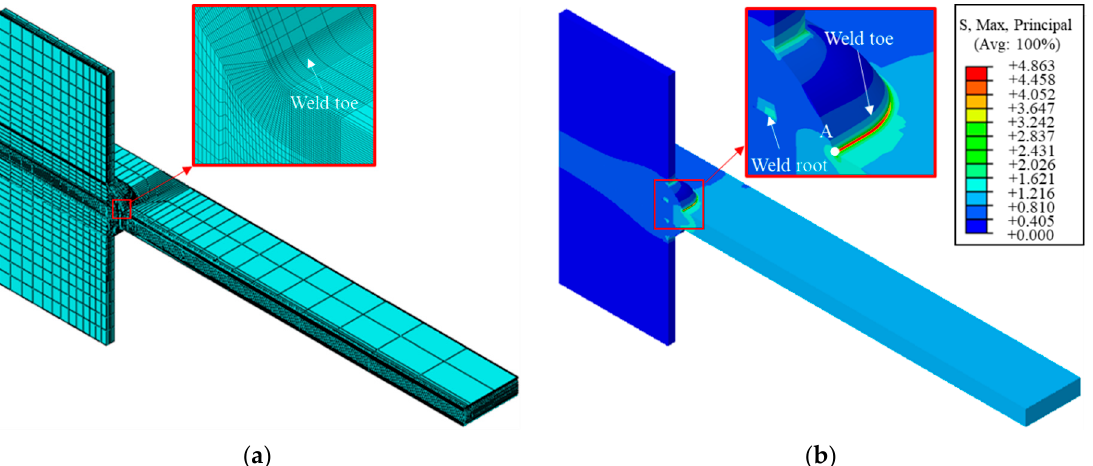
Figure 3. The finite element (FE) model: ( a ) the mesh; ( b ) the analysis result.